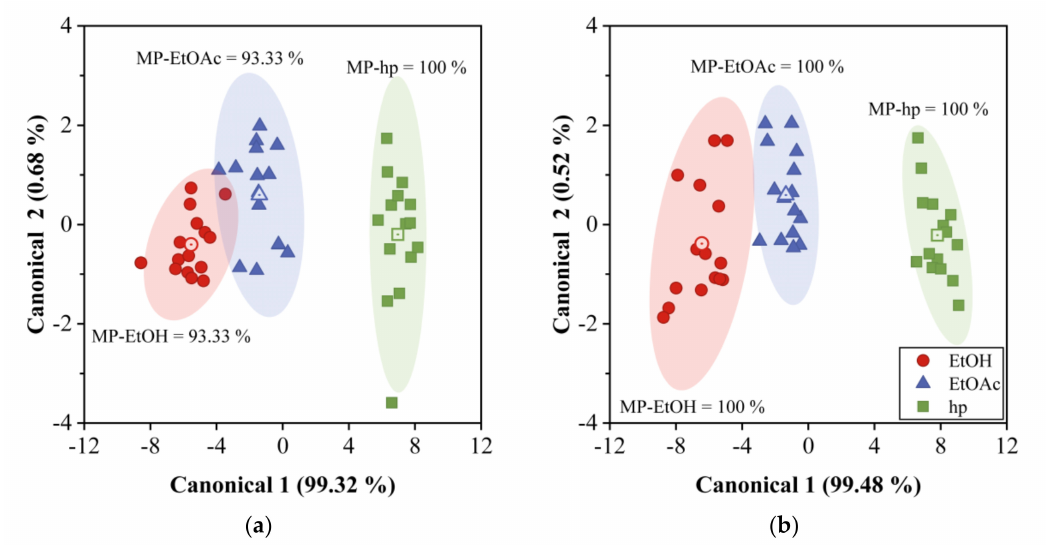
Figure 10. DA results of partition coe ffi cient ln ( K ) for the QCM gas sensor array. ( a ) 12QCM-SA and ( b ) 30QCM-SA. Ethanol, ethyl acetate, and heptane data are enclosed by ellipses calculated at 2 σ (95%